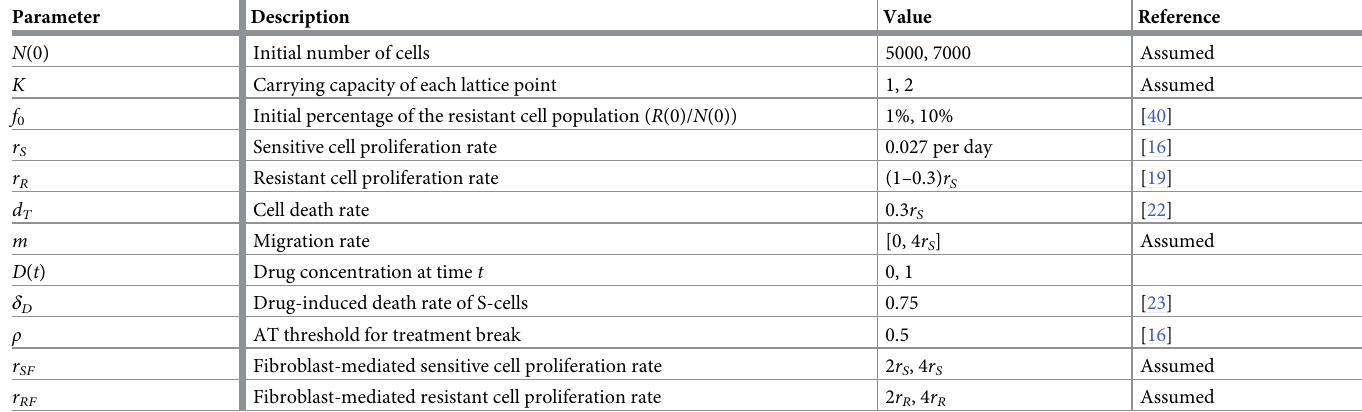
Table 1. The parameter values are listed in the following table.